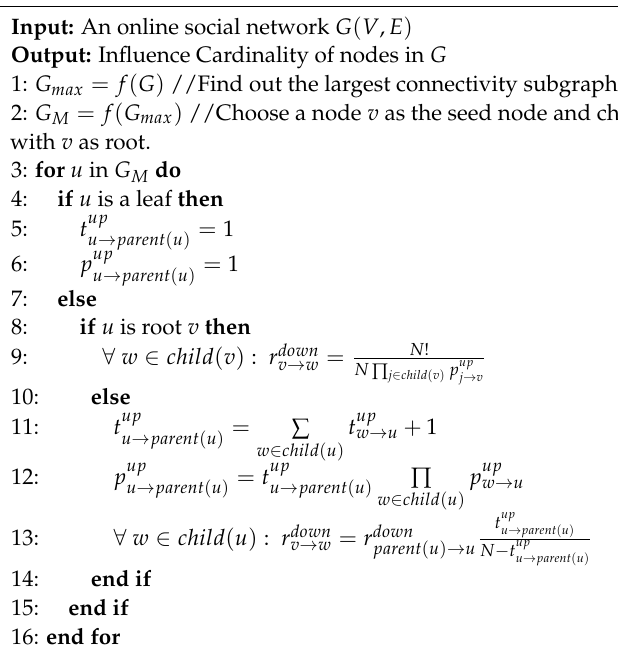
Algorithm 1 Calculate the influence cardinality based on